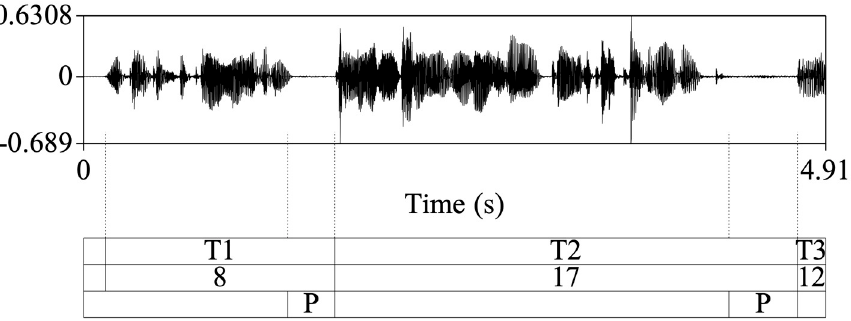
Figure 1. Example of the verse-wise segmentation (top tier, verses T1, T2, and start of T3), the number of phonological syllables in the corresponding verse (middle tier), and the silent pause intervals (bottom tier) marked with “P”.